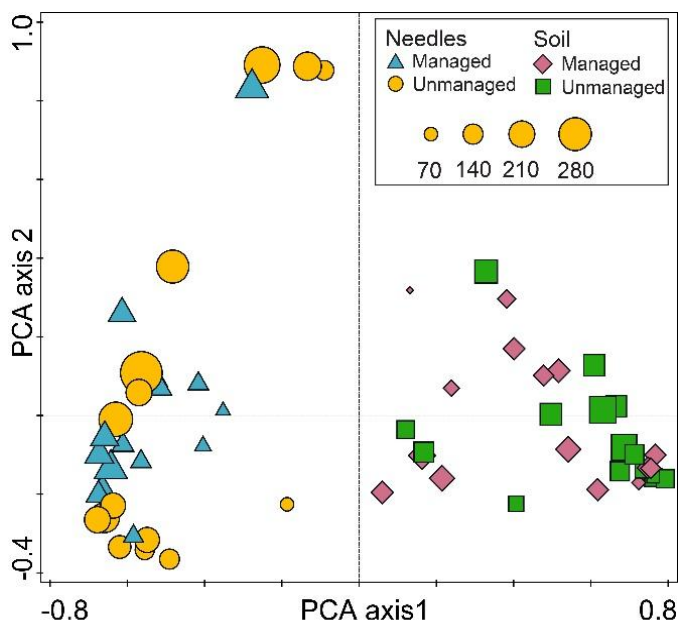
Figure 4. Ordination diagram based on principal component analysis (PCA) of fungal communities in living needles and soil from managed and unmanaged Pinus sylvestris forest stands from three national parks in Lithuania. Each point in the diagram represents a single site, and the size of the point reflects the richness of fungal taxa.